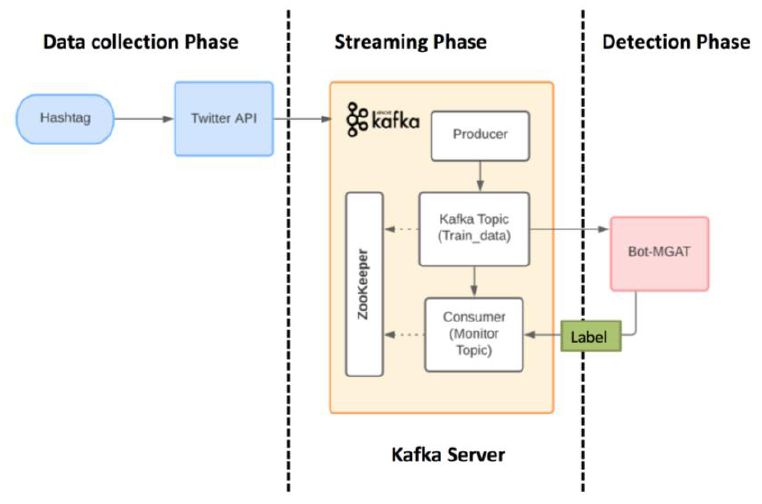
Figure 1. SEBD framework.